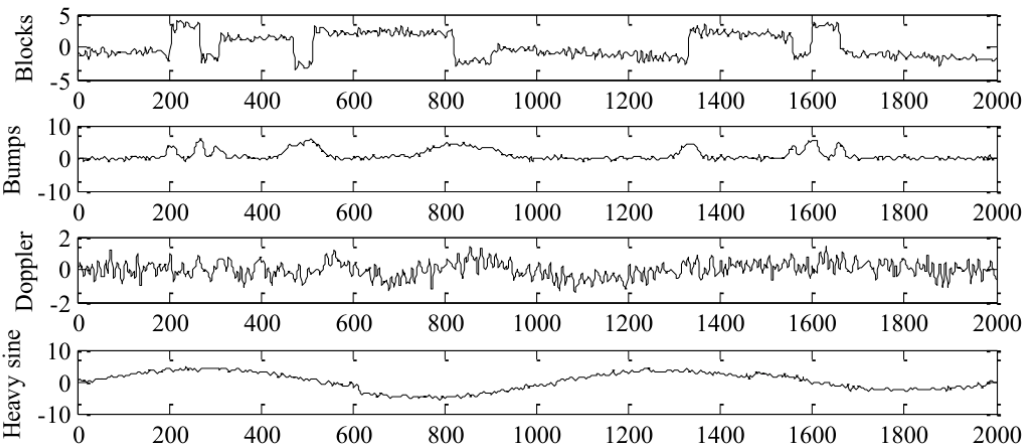
Figure 5. Results of EMD denoising (the original signal SNR: 4dB).